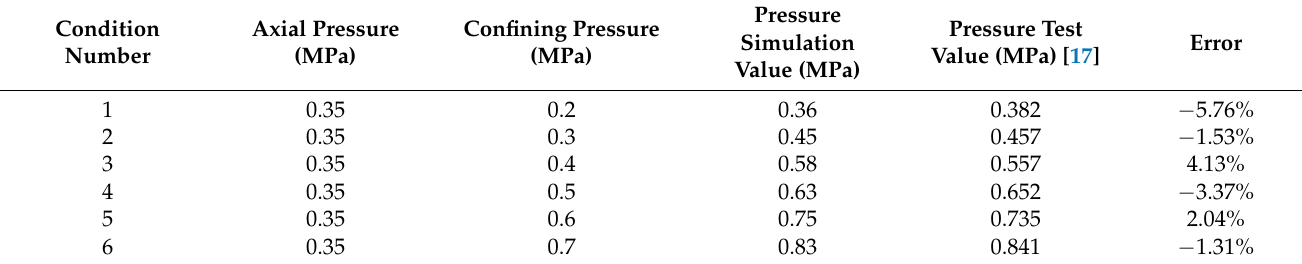
Table 2. The setting of working conditions and fracture initiation pressure simulation results.